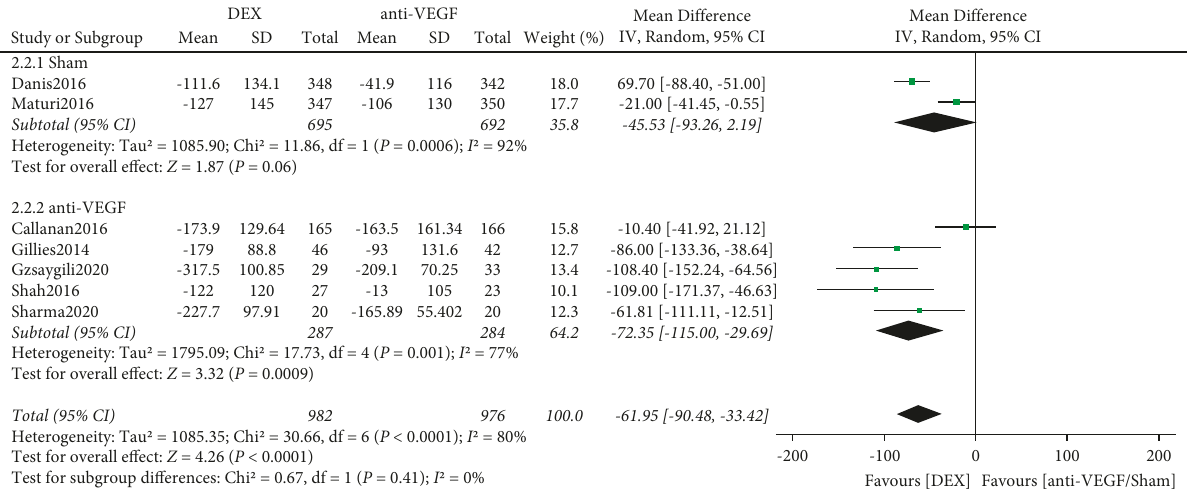
Figure 3: Forest plots of CRT for